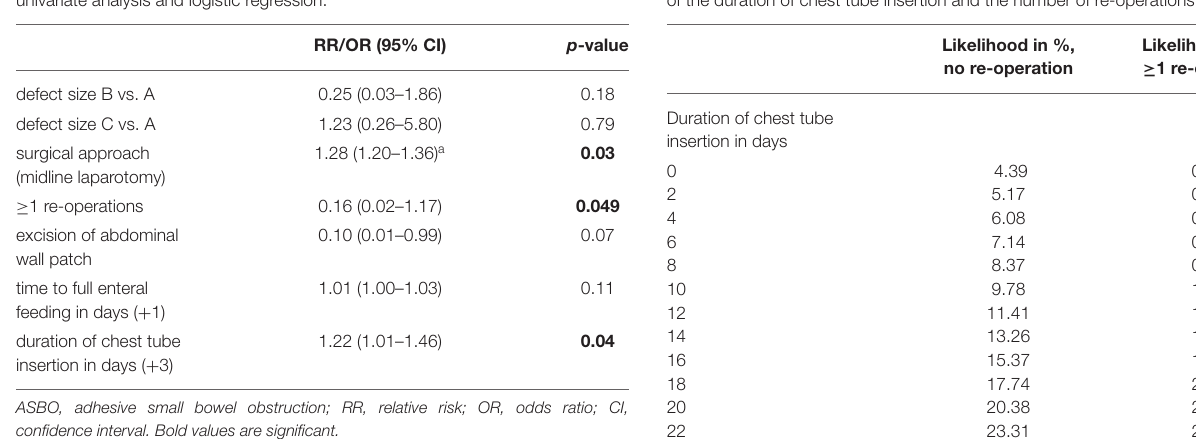
TABLE 10 | Predictors of adhesive small bowel obstruction (ASBO) using univariate analysis and logistic regression.